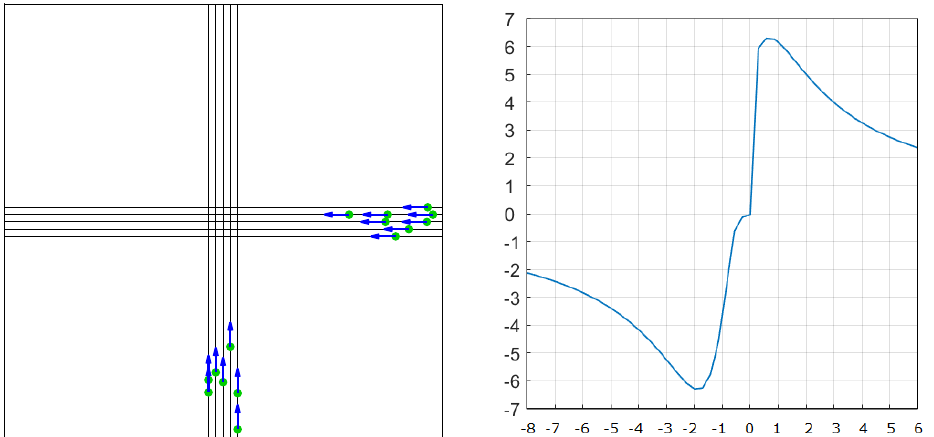
Figure 16. S-N and E-W flows, crossing at 90°. Traffic situation on the left and complexity function of time on the right.